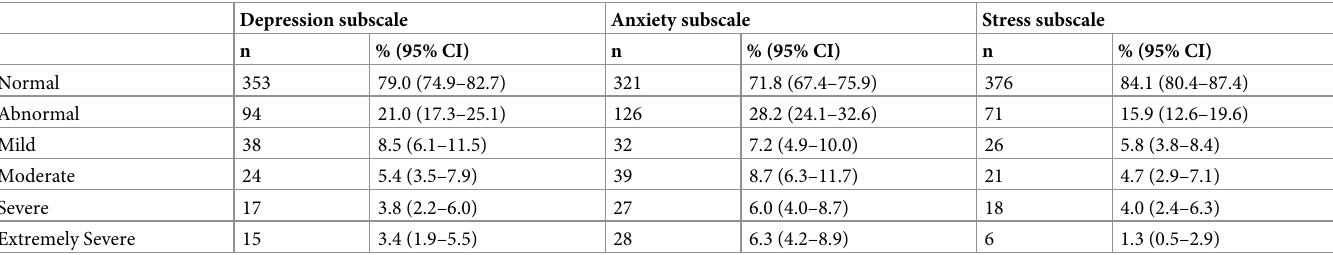
Table 3. Levels of depression, anxiety and stress among frontline healthcare workers in Gaborone, Botswana (n = 447). Depression subscale Anxiety